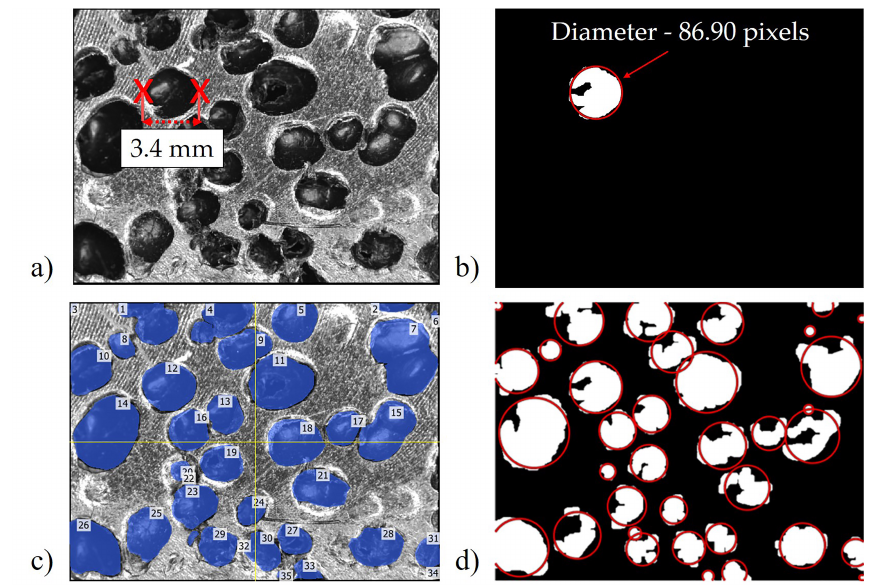
Figure 4. Cell area validation using a Keyence digital microscope. ( a ) Measuring diameter as seen from the Keyence microscope. ( b ) Measuring the effective diameter of the same cell using the new proposed method. ( c ) Manually measuring the area of each cell using the Keyence microscope. ( d ) Automated measuring of the effective diameters of all the